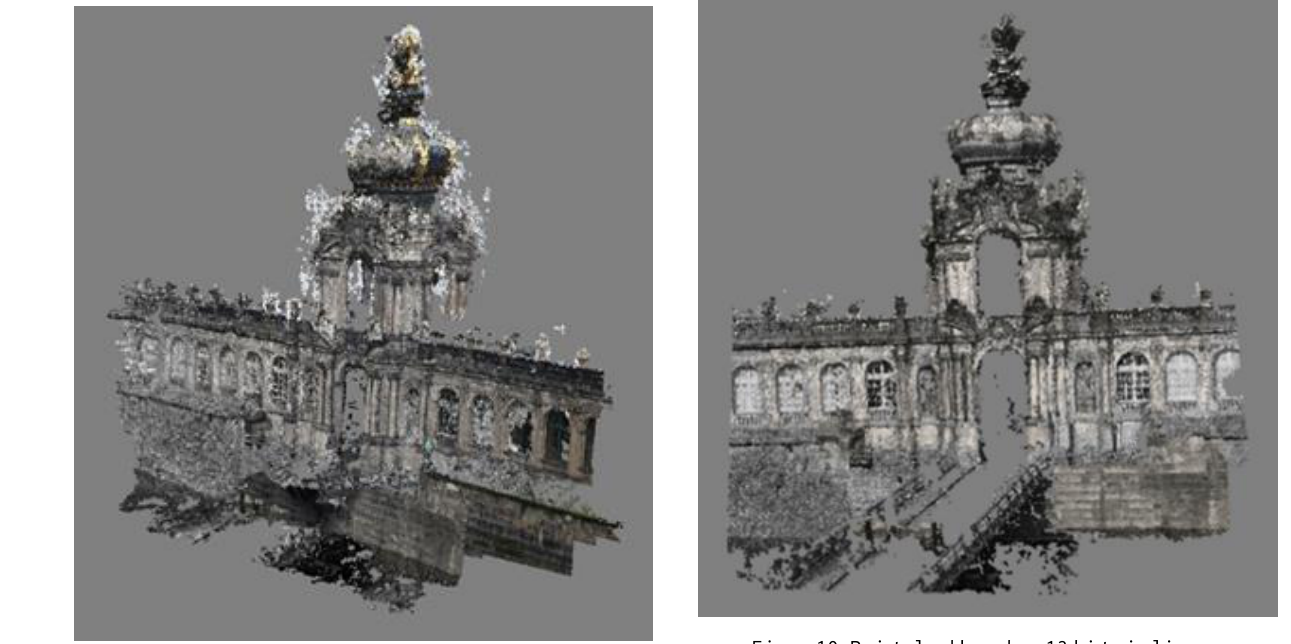
Figure 9. Point cloud generated on the basis of both, historical as well as current images